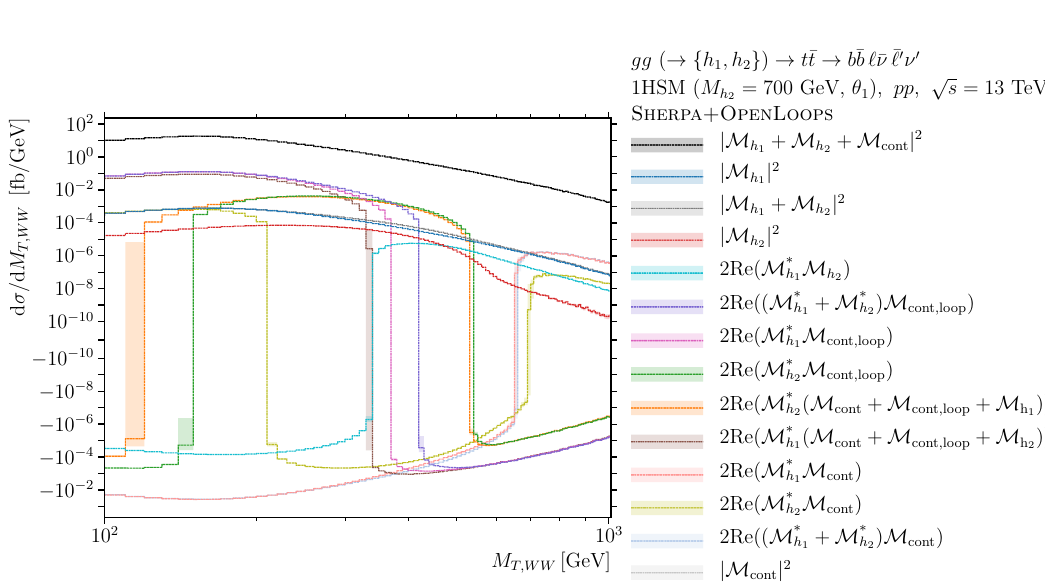
Figure 10 . M distributions for the signal process gg ( t ¯ t = 700 GeV, θ 1 ) including its interference with the background in pp collisions at √ s = 13 TeV. ( M h 2 Other details as in figure 4.